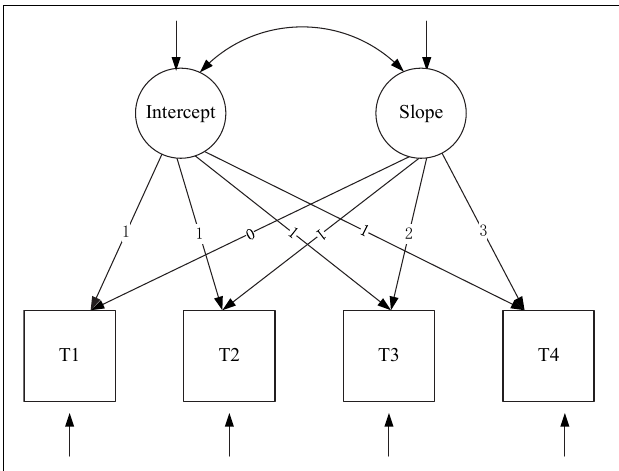
FIGURE 3 | Linear unconditional latent variable growth model.